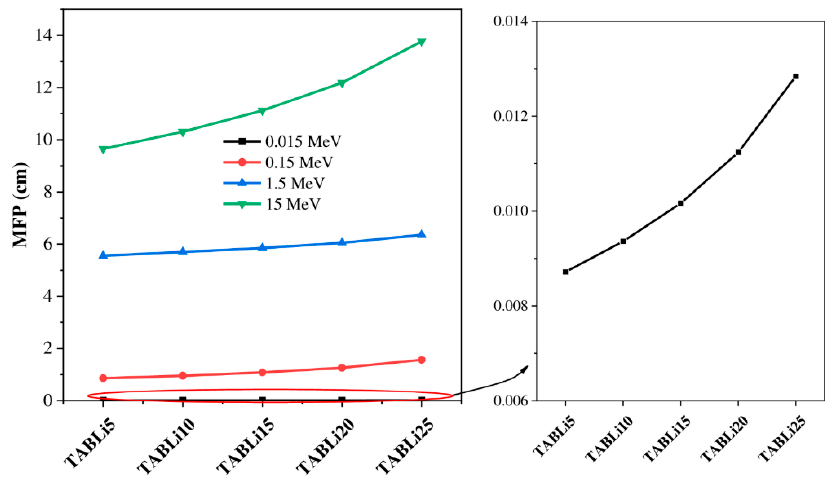
Figure 12. Variation of the investigated glasses’ mean free path versus LiO 2 concentration.